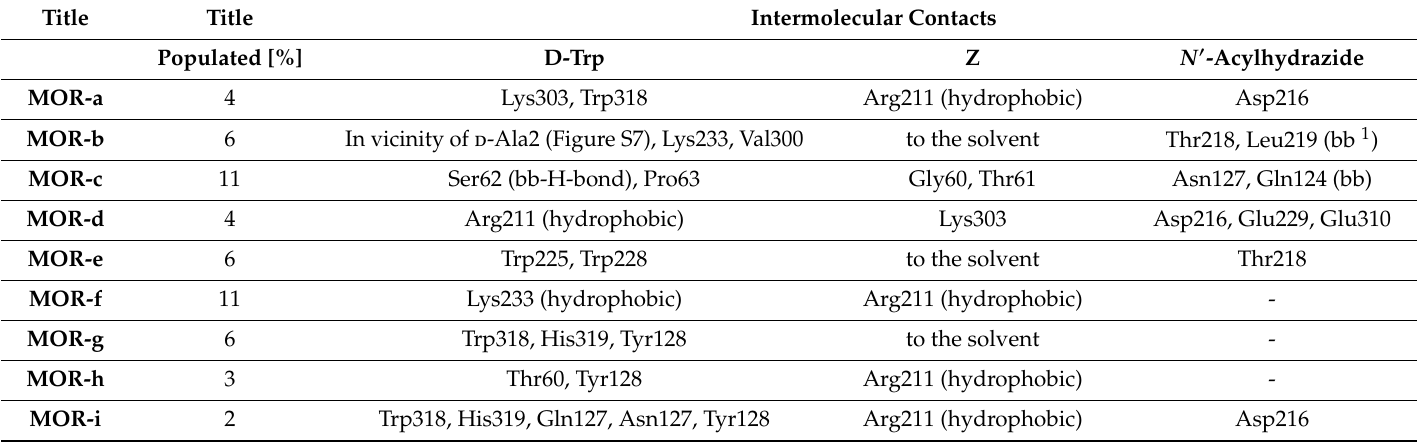
Table 3. Description of representative structures for clusters related to -NH-NH < -Z- d -Trp